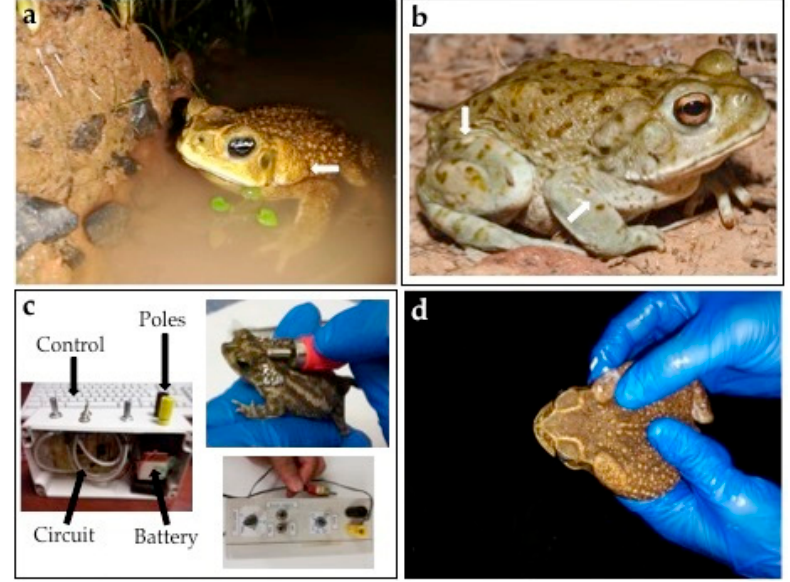
Figure 1. Species of true toads, with white arrows indicating skin macroglands. ( a ) Adult specimen of Rhinella horribilis (Wiegmann, 1833). ( b ) Adult toad of Incilius alvarius (Girard, 1859); (© 2014 Hunter McCall). ( c ) Mild electrical stimulation of an adult male of Rhinella centralis (Narvaes and Rodrigues, 2009) employing a transcutaneous amphibian stimulator [15]. ( d ) Stimulation of Rhinella horribilis by gentle compression of the parotoid glands.